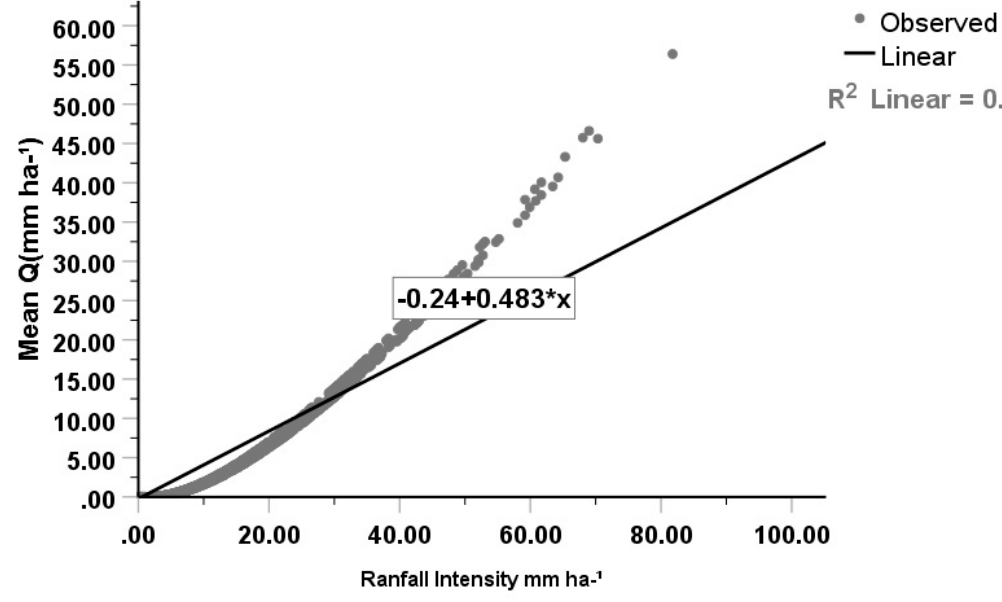
Figure 9. Linear regression analysis between runoff and rainfall intensity.